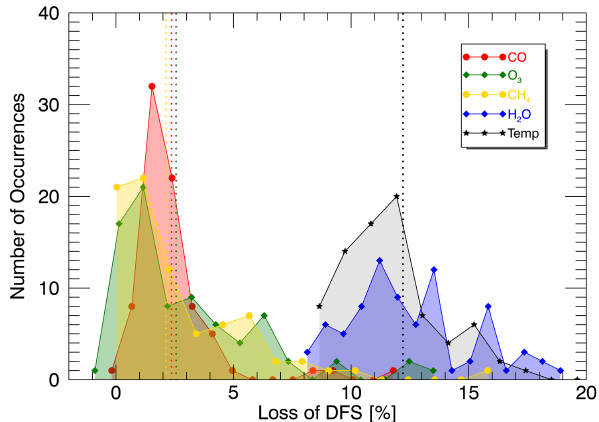
Figure 9. Histograms of 15 equally spaced bins showing the percent Figure 10. Histograms of 15 equally spaced bins showing the loss loss in DFS by creating a coarse vertical grid from the cumulative in DFS by using a constant globally optimised vertical grid vs. an trace of A vs. the coarse grid from the iterative method. The dotted atmosphere specific grid. The dotted vertical lines show median val- vertical lines show the median values of the 80-atmosphere distri- ues of the 80-atmosphere distribution, where the temperature and bution. H 2 O medians overlay each Table 1. Summaries of the ensemble results from Figs. 8–10. The second column shows the ensemble mean DFS for each retrieval using the iterative method. The last three columns show the median percent loss of DFS for the histograms displayed. Eq PRE Diag( A )